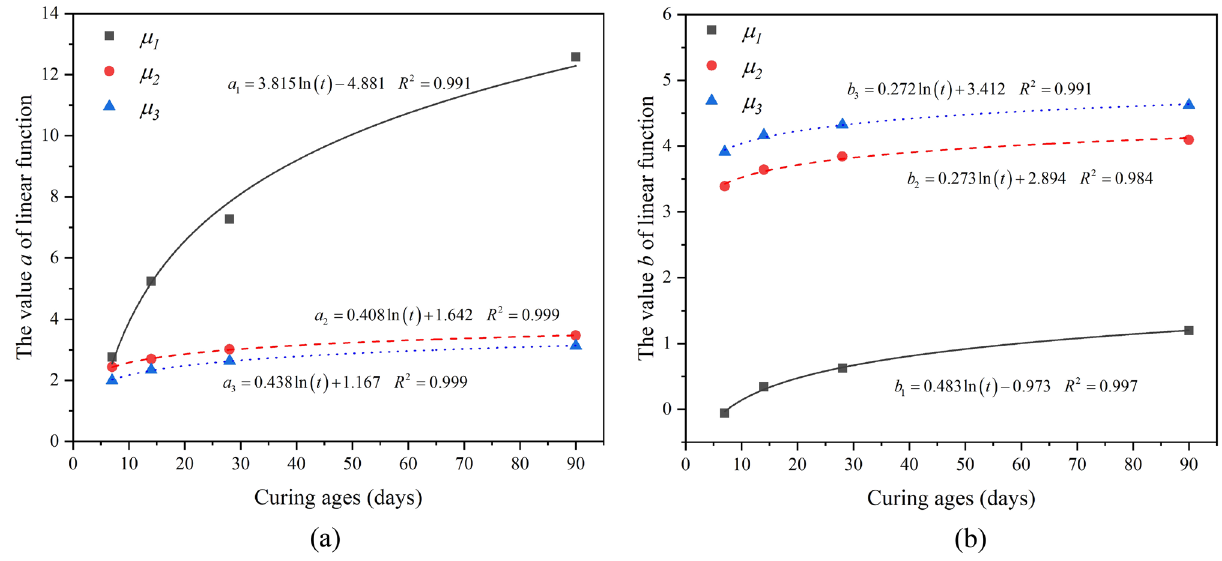
Figure 12. Relationships between the values a and b of a linear function and curing ages, (a) a and (b) b .